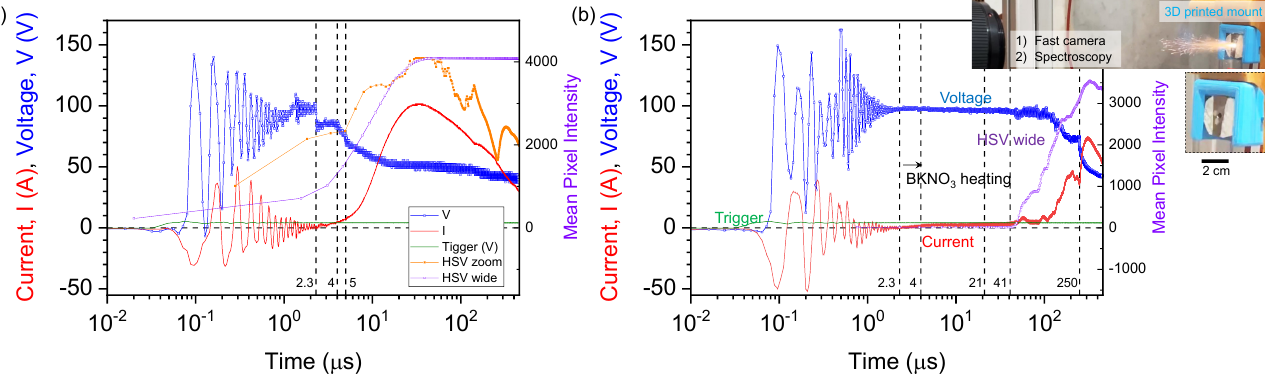
Figure 4. Plots showing the time evolution of current I and voltage V transients for ( a ) a silicon bridge in free space, R ≈ 18 Ω , including mean pixel intensity of high-speed camera video in both a narrow, zoomed field-of-view focused on the bridge and a wide field-of-view focused on an area highlighted with the white dotted circle in Figure 1a (the wide view was from another bridge fired under the same conditions) and ( b ) a silicon bridge loaded with < 10 mg BKNO 3 , R ≈ 54 Ω , including the mean pixel intensity from a wide field-of-view. The inset shows a phone-captured frame of the explosion event triggered by a µ-bridge loaded with < 10 mg BKNO 3 . The video was taken from another bridge fired under similar conditions. The PCB was mounted in a 3D printed holder for a fixed position to record high-speed video (HSV) and spectroscopic